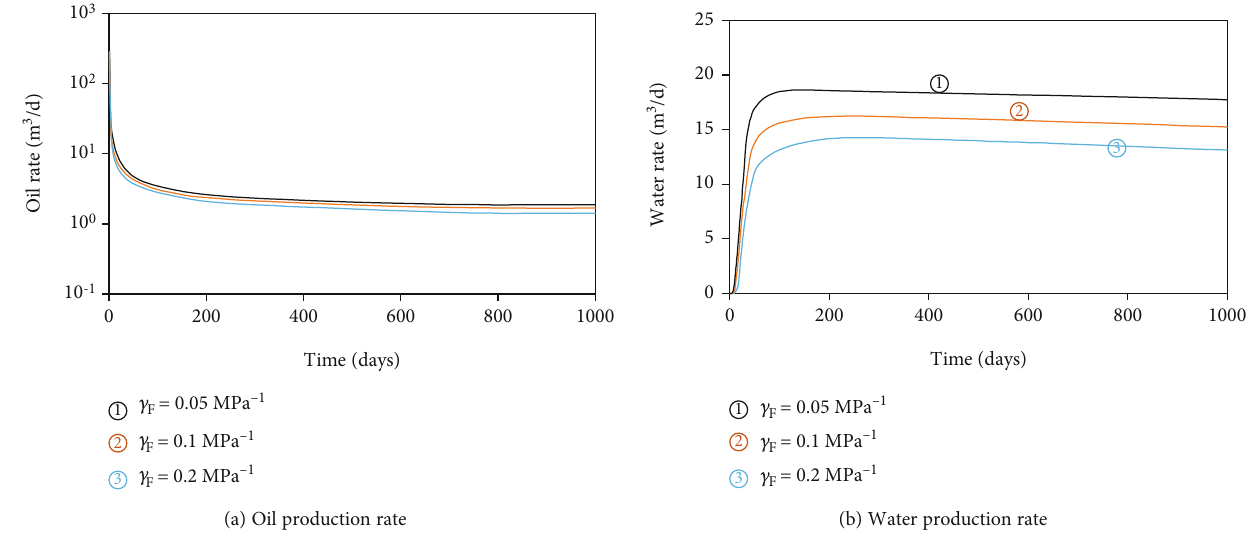
Figure 8: E ff ect of fracture permeability modulus on oil and water production rates.